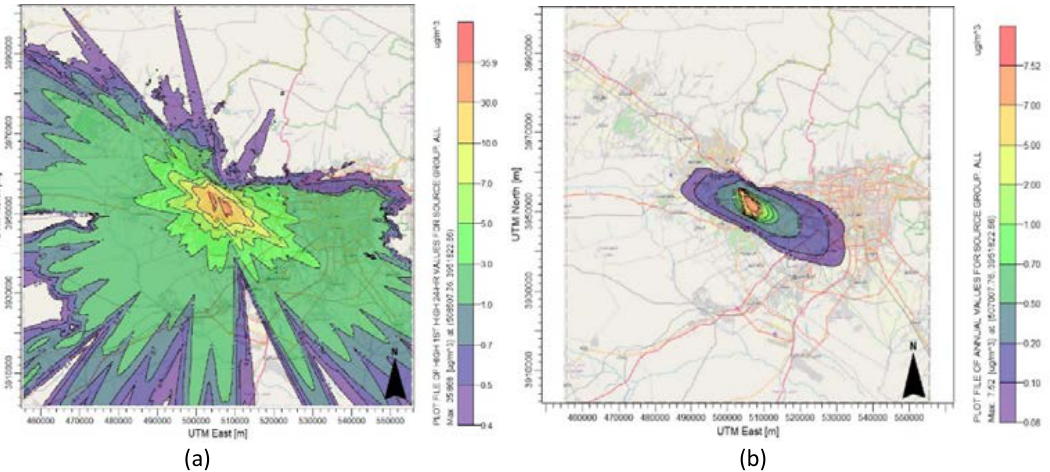
Fig. 5: Dispersion of PM 2.5 from the sand and gravel product plants: (a) 24-hour average and (b) annual average